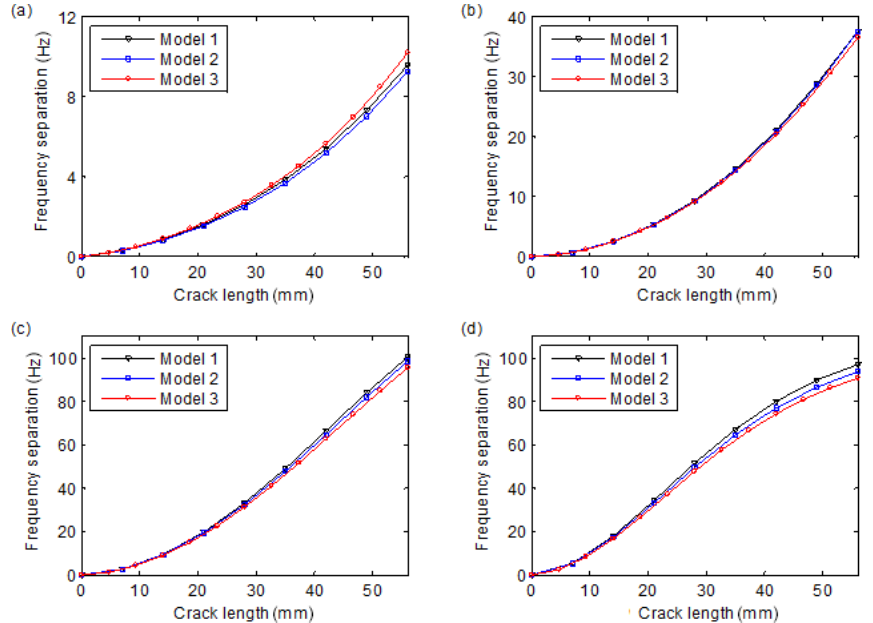
Figure 10. Variation of frequency separations versus crack length: (a) 1ND, (b) 2ND, (c) 3ND and (d) 4ND. Models 1, 2 and 3 possess 4260, 6780 and 14400 nodes, respectively.